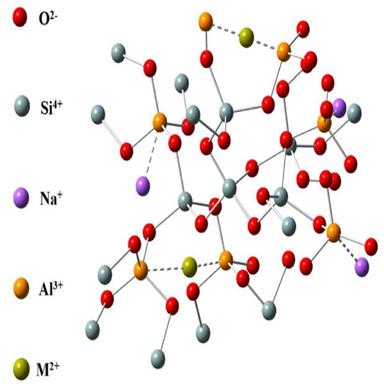
Field picture of the pilot test.